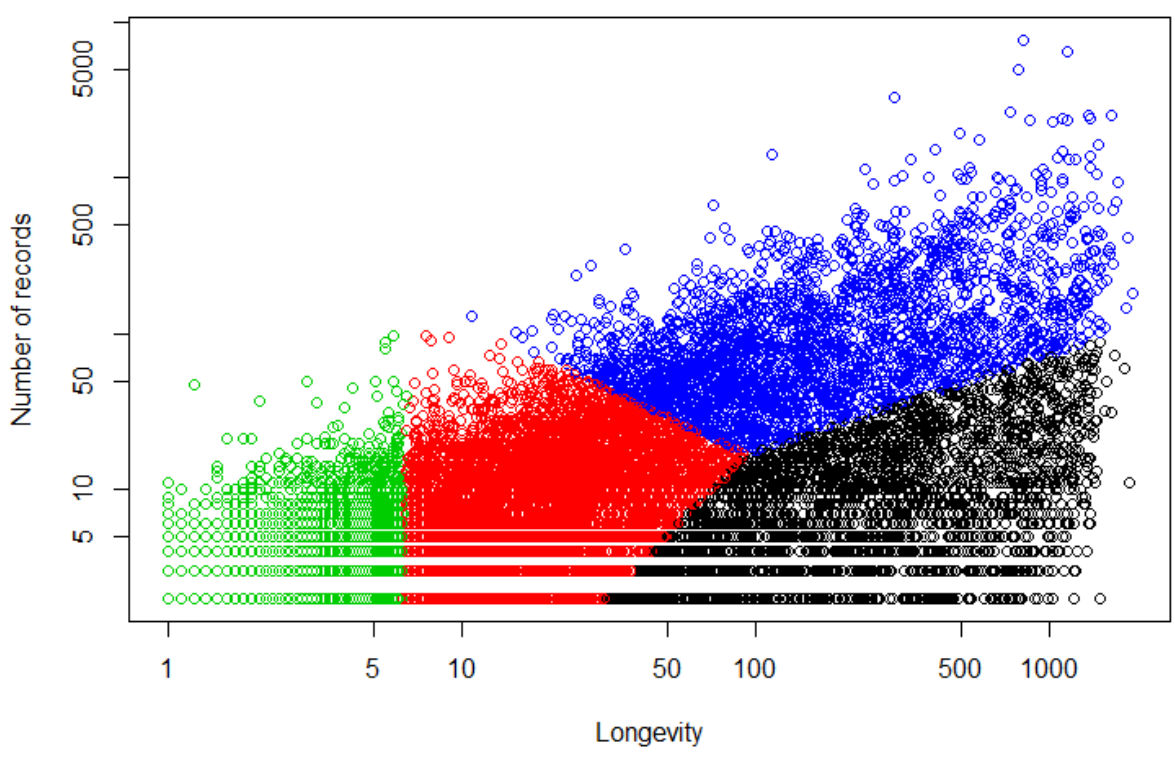
Figure 2. Clustering solution using 4 clusters.